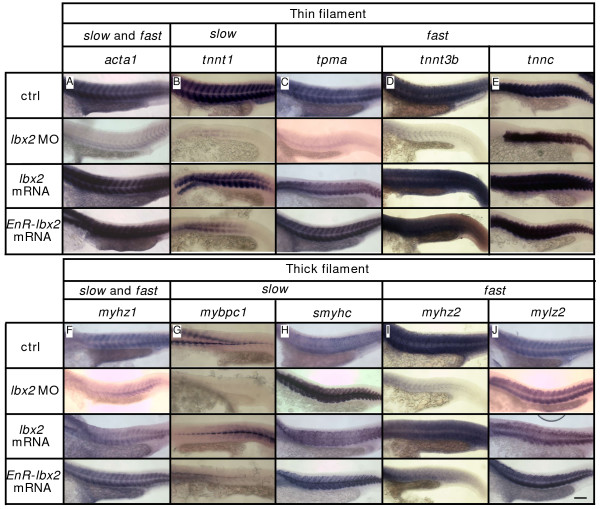
Expression of thin and thick myofilament genes is downregulated by interference with Lbx2 activity. A-J: Analysis of myofilament gene expression. Expression of acta1 (A), tnnt1 (B), tpma (C), tnnt3b (D), tnnc (E), myhz1 (F), mybpc1 (G), smyhc (H), myhz2 (I), mylz2 (J) in control, lbx2-MO injected, lbx2 mRNA injected, and Engrailed suppresser domain fused lbx2 (EnR-lbx2) mRNA injected embryos. Expression of acta1 (A, ctrl: 28/28, lbx2-MO: 0/33, lbx2-mRNA: 9/10, EnR-lbx2 mRNA: 8/8, numerator indicates number of embryos with normal expression, and denominator indicates number of examined embryos), tnnt1 (B, ctrl: 19/19, lbx2-MO: 7/22, lbx2-mRNA: 12/12, EnR-lbx2 mRNA: 17/17), tpma (C, ctrl: 16/16, lbx2-MO: 2/20, lbx2-mRNA: 13/14, EnR-lbx2 mRNA: 10/11) and tnnt3b (D, ctrl: 13/13, lbx2-MO: 0/7, lbx2-mRNA: 7/7, EnR-lbx2 mRNA: 4/4) is reduced by lbx2-MO, but not tnnc (E, ctrl: 17/17, lbx2-MO: 18/22, lbx2-mRNA: 10/10, EnR-lbx2 mRNA: 16/16). Expression of myhz1 (F, ctrl: 25/25, lbx2-MO: 3/16, lbx2-mRNA: 7/8, EnR-lbx2 mRNA: 8/8), mybpc1 (G, ctrl: 15/15, lbx2-MO: 10/20, lbx2-mRNA: 13/14, EnR-lbx2 mRNA: 5/8) and myhz2 (I, ctrl: 17/17, lbx2-MO: 0/5, lbx2-mRNA: 9/9, EnR-lbx2 mRNA: 8/8) is reduced by lbx2-MO, but smyhc (H, ctrl: 36/36, lbx2-MO: 24/29, lbx2-mRNA: 8/8, EnR-lbx2 mRNA: 12/12) and mylz2 are unaltered (J, ctrl: 15/15, lbx2-MO: 14/15, lbx2-mRNA: 10/10, EnR-lbx2 mRNA: 7/7). No obvious difference can be detected between embryos injected with lbx2 mRNA and embryos injected with EnR-lbx2 mRNA. (A-J) Whole mounts, lateral views, rostral toward the left, dorsal toward the top. Scale bar: 100 μm.